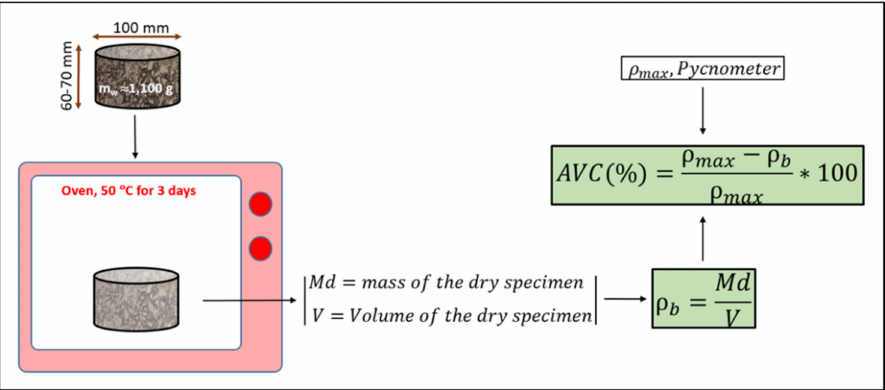
Figure 3. Scheme of the calculation of the bulk density and the air voids content for gyratory speci-